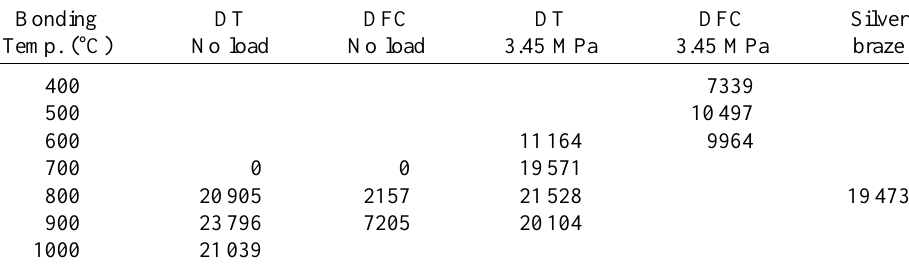
TABLE II. Room temperature breaking strength (Newtons) for the diffusion bonded samples having a bonded area of 1.13 3 10 2 4 m 2 . DT refers to the diamond-turned finish; DFC refers to the diamond fly-cut finish.